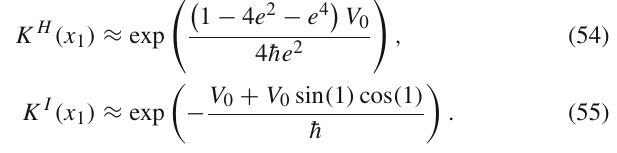
Fig. 4 The top figure shows Re we set V 0 = 3, (cid:6) = 3 and x 1 = 3 and the star expresses N = − i . On the other hand, in the bottom figure we set V 0 = 9 / 2, (cid:6) = 3 and x 1 = 3 / 2 and this figure shows that the saddle points of the action (15) is N s also coincides with the Euclidean saddle point N = − i